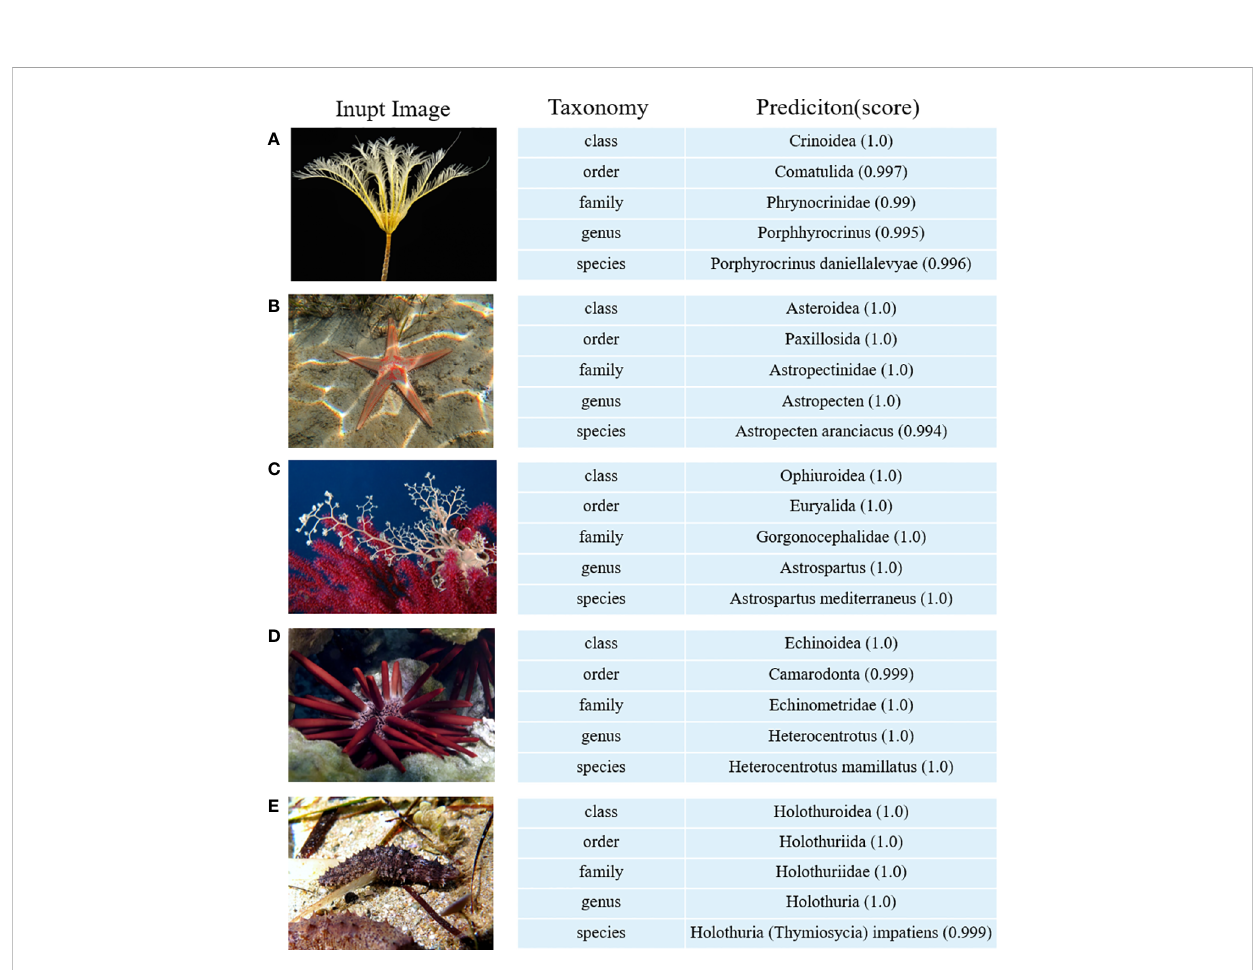
FIGURE 7 Illustration of image prediction results by EchoAI. (A) belongs to the category Crinoidea (class classi fi cation level); (B) belongs to the category Paxillosida (order classi fi cation level); (C) belongs to the category Gorgonocephalidae (family classi fi cation level); (D) belongs to the category Heterocentrotus (genus classi fi cation level); (E) belongs to the category Holothuria (Thymiosycia) impatiens (species classi fi cation level).